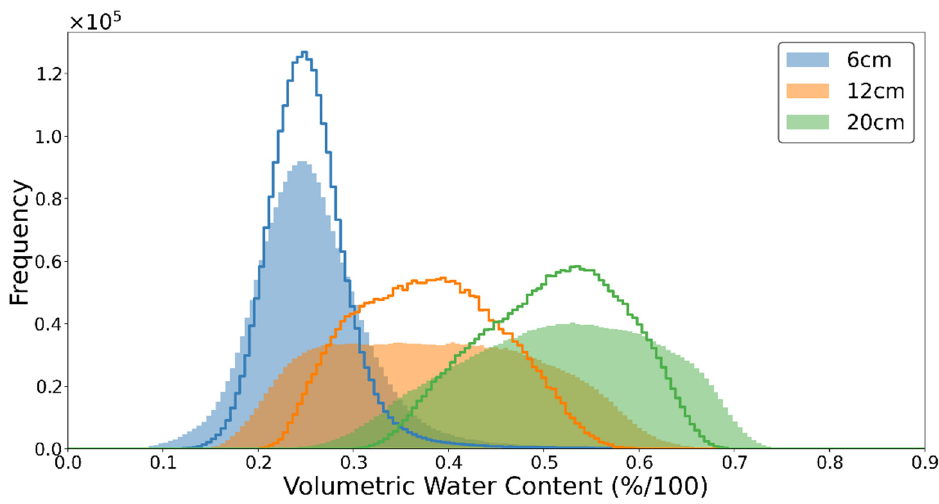
Figure 6. Distribution of SAR-derived volumetric water content for 6 cm, 12 cm, and 20 cm depths. The shaded histogram represents the SAR-derived soil moisture values and the lines are the associated random forest predictions for each depth.